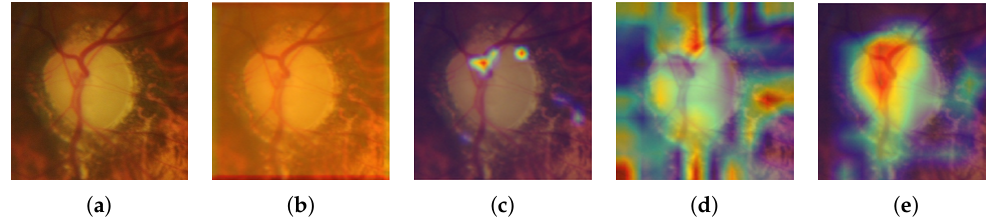
Figure 6. Dataset-OD: Visualization of intermediate layers, at the end of each ResNet block, of ResNet-152-M. The leftmost image is the input image, and the rightmost image is the last convolutional layer of the network. ( a ) An original funuds image inpu; ( b ) The 1st ResNet block output; ( c ) The 2nd ResNet block output; ( d ) The 3rd ResNet block output; ( e ) The final